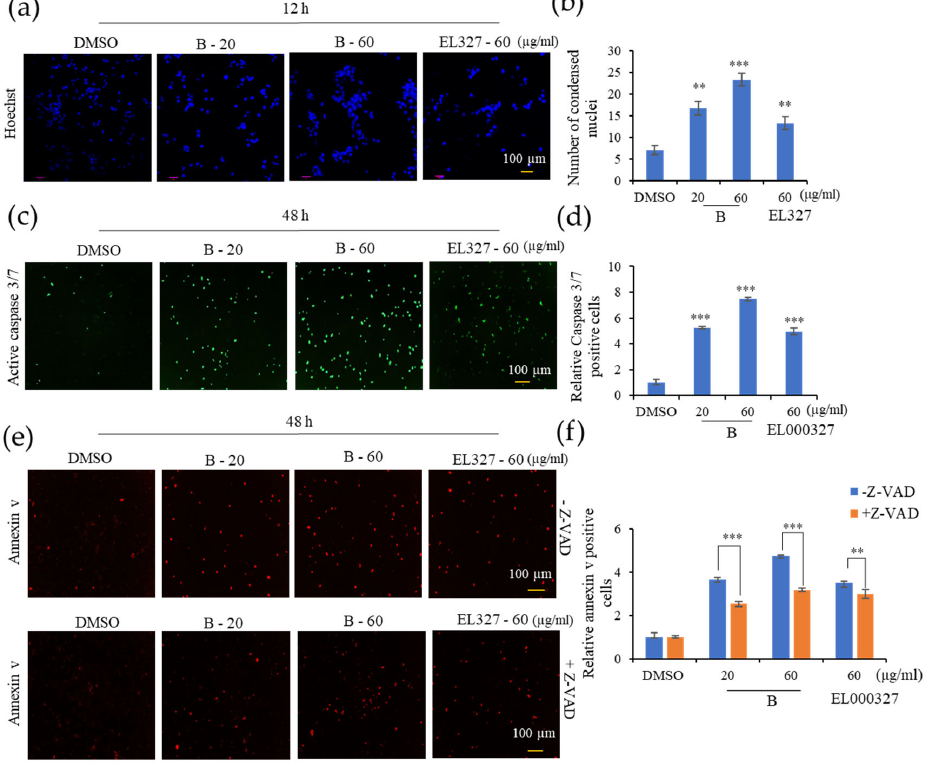
Figure 3. B induces caspase dependent apoptosis in Caco2 cells. ( a ) Nuclei condensation of Caco2 cells upon treatment with B (20, 60 μ g/mL) or EL000327 (60 μ g/mL) for 12 h, as determined by Hoechst staining. Arrowheads indicate nuclear condensation in cells. ( b ) Quantification of condensed nuclei in Caco2 cells treated with indicated concentrations of B or EL000327. ( c ) Caspase 3/7 (green) staining of Caco2 cells treated with B (20, 60 μ g/mL) or EL000327 (60 μ g/mL) for 48 h. ( d ) Quantification of apoptotic cells stained with Caspase 3/7 after treatment with the indicated concentrations of B or EL000327. (e) Annexin V staining of Caco2 cells treated with B (20, 60 μ g/mL) or EL000327 (60 μ g/mL) for 48 h in the presence or absence of the caspase inhibitor Z ‐ VAD ‐ FMK (10 μ M). ( f ) Quantification of apoptotic cells stained with Annexin V after treatment with the indicated concentrations of B or EL000327 in the presence or absence of Z ‐ VAD ‐ FMK (10 μ M). ( g ) Flow cytometric analysis of dead cells stained by Annexin v ‐ FITC (apoptotic cells) and PI (necrotic cells) upon the treatment of B (20, 60 μ g/mL) or EL000327 (60 μ g/mL) for 48 h in the presence or absence of Z ‐ VAD ‐ FMK (10 μ M). ( h ) Quantification of the percentage of apoptotic cells treated with